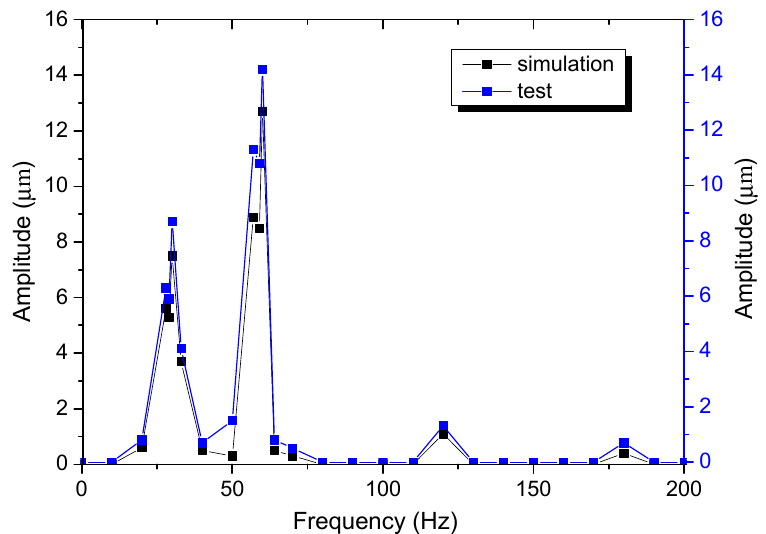
Figure 14. Comparison between simulation results and test results, when λ = 0.01 and speed ratio is S = 2.47. S =